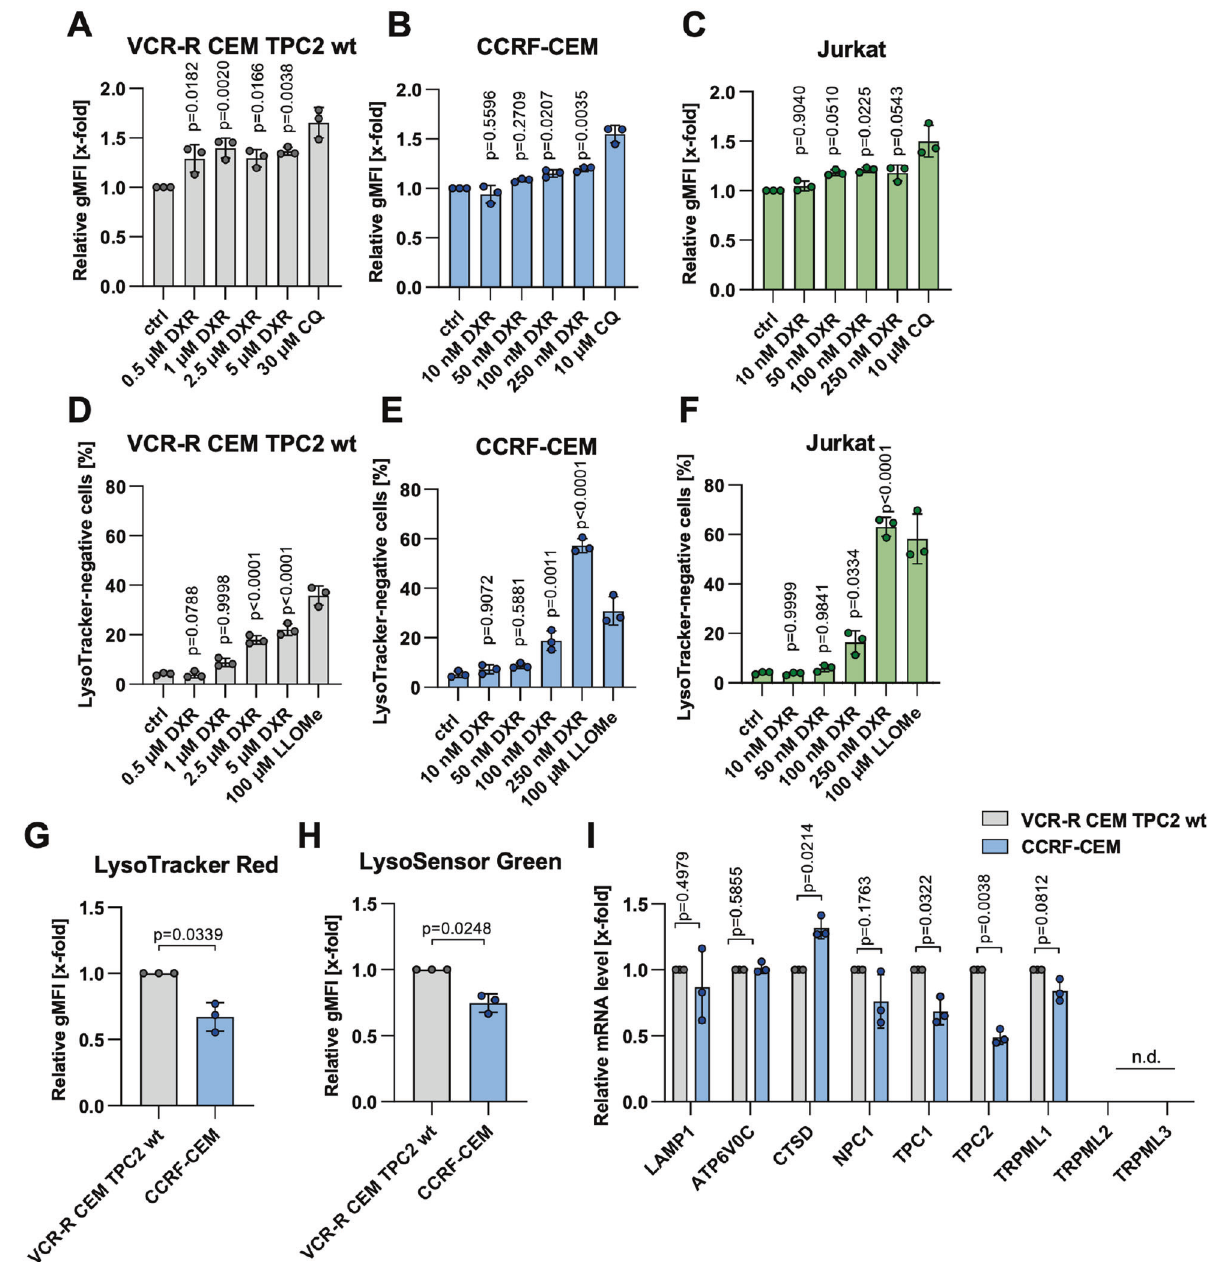
Fig. 1 Role of lysosomes in chemo response and resistance. A – C Lysosomal volume was assessed by LysoTracker Green staining and fl ow cytometry after 4 h (VCR-R CEM TPC2 wt), A or 8 h (CCRF-CEM, B Jurkat, C of treatment). D – F Lysosomal damage was assessed by quanti fi cation of LysoTracker-negative cells by fl ow cytometry after 24 h of treatment. Chloroquine (CQ) A – C and L-Leucyl-L-Leucine methyl ester (LLOMe) D – F served as a positive control. G Lysosomal volume was assessed by LysoTracker Red staining and fl ow cytometry. H Lysosomal acidity was assessed by LysoSensor Green staining and fl ow cytometry. Cells with more acidic lysosomes show increased LysoSensor fl uorescence. I The expression of lysosomal genes was analyzed by qPCR. Data were acquired from at least three independent experiments. Statistical signi fi cance was analyzed by one-way ANOVA with Dunnett ’ s post-test. A – F or student ’ s t -test with Welch ’ s correction G – I . Data are shown as mean ±